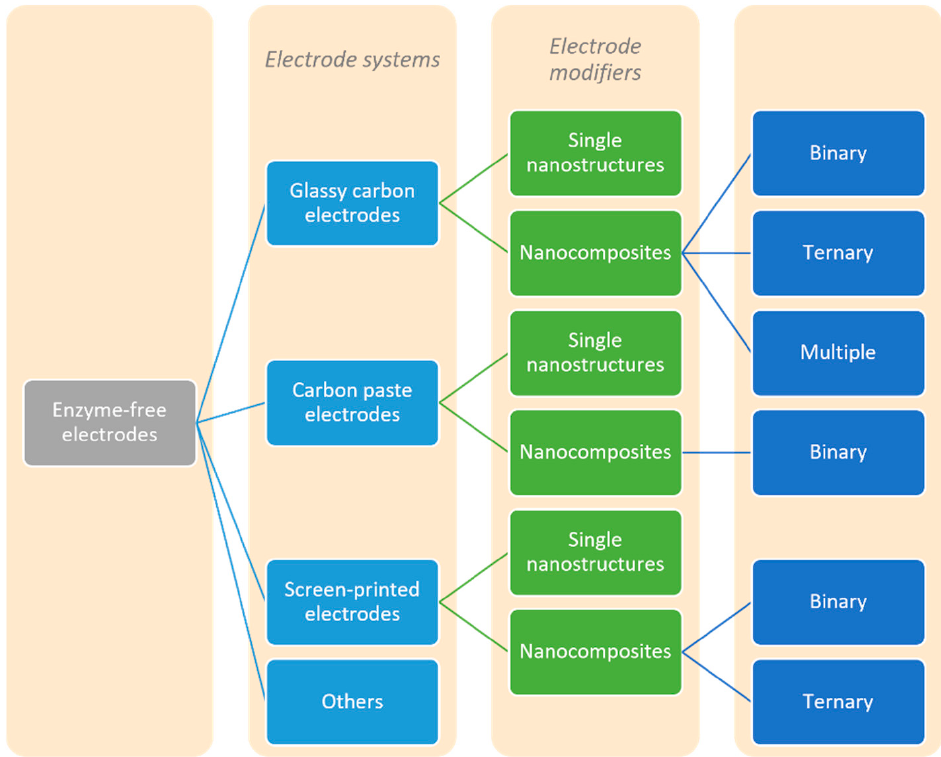
Figure 1. A schematic representation of the content reviewed in this